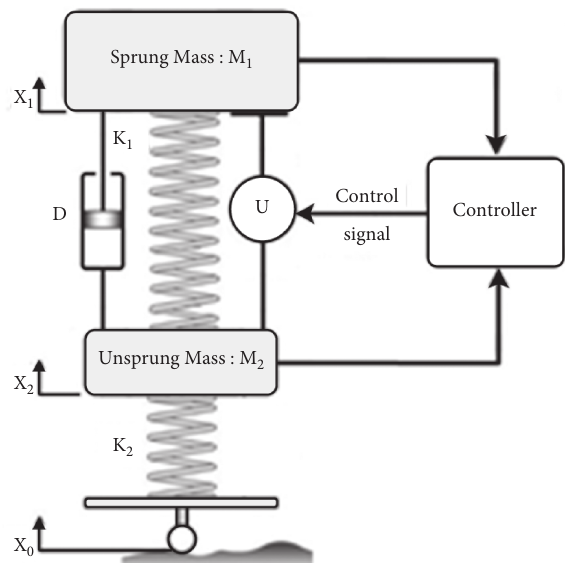
Figure 1: Quarter car model equipped with the active suspension system